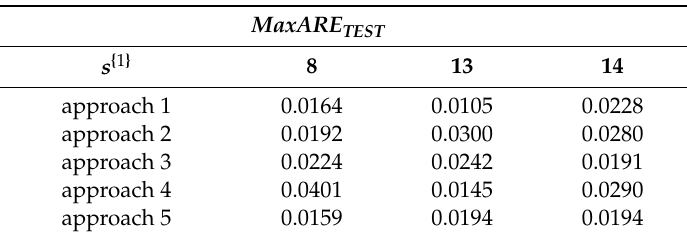
Table 2. Maximum absolute relative error obtained for the test stages for neural network structures with 𝑠 {(cid:2869)} = 8, 13, and 14 neurons.